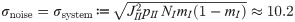
Periodically driven single population network.Dependence of the modulations of the mean activity and covariances on the driving frequency ω. A Amplitude of modulation of mean activity. B Phase of modulation of mean activity relative to the external drive. C Amplitude of modulation of covariances. D Phase of modulation of covariance relative to the external drive. In all panels, the analytical predictions (Eqs (9) and (39)) are shown as solid black curves. The black curve is the complete solution. The different contributions to the time-dependent covariances, identified in Eq (12), are shown separately: The Sh-term in red, the Sm-term in blue, their sum in purple, and the a-term in orange. Numerical solutions of the full mean-field equations (Eqs (5) and (6)) are shown as stars and simulation results by dots (only indicated in the legend of A). The numerical results are obtained by using the integrate.ode-method from the python-package scipy [41] with the option “lsoda”, meaning that either implicit Adams- or backward differentiation-algorithms (depending on the given problem) are used. Network parameters: Number of neurons NI = 5000, connection probability pII = 0.1, coupling strength JII = −1, mean activity mI ≈ 0.3, and σnoise=σsystem ≔ JII2pIINImI(1−mI)≈10.2.